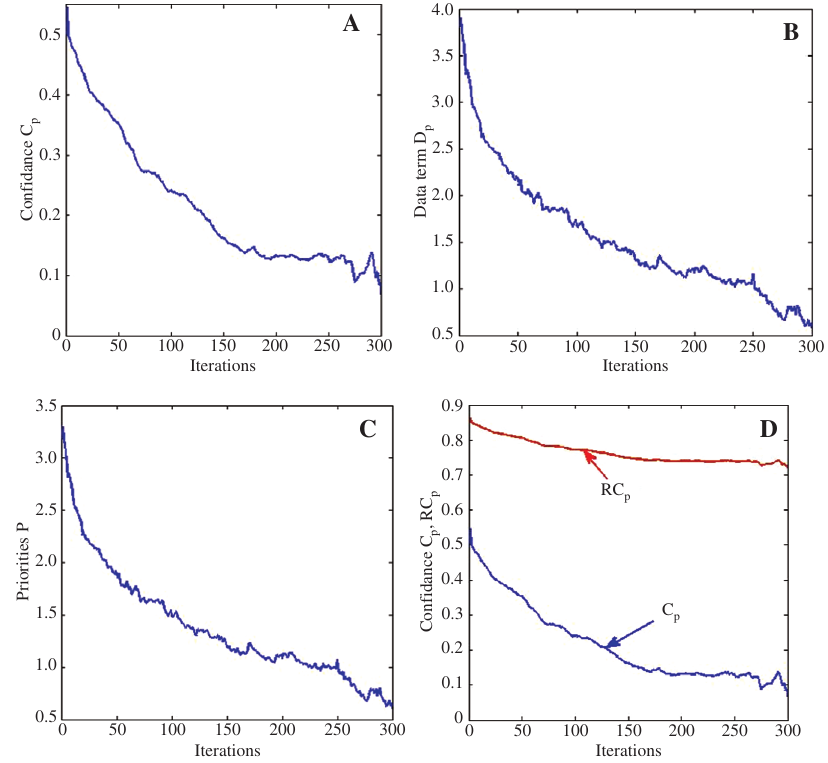
. (B) Data Term D p